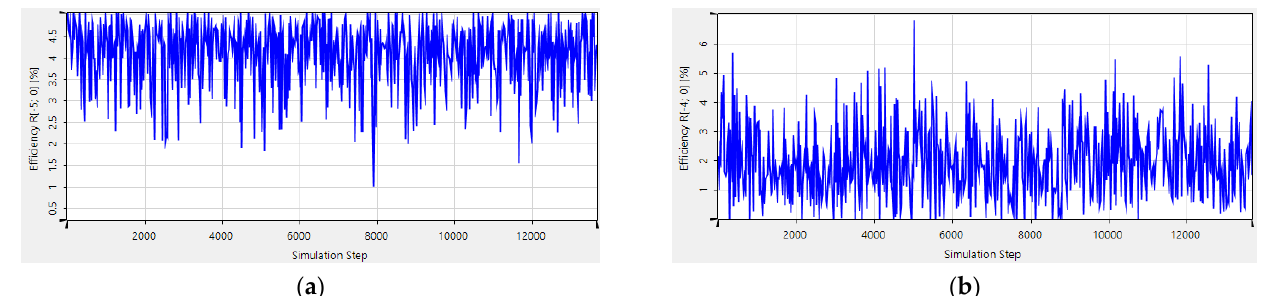
Figure 26. The diffraction efficiency after 13,000 iterations. ( a ) The 5th order; ( b ) the 4th order.